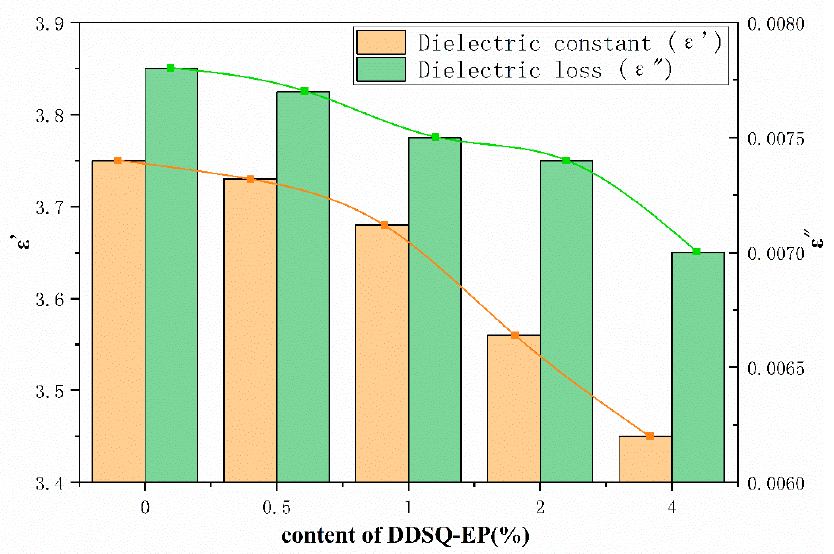
Figure 13. Dielectric constant ( ε′ ) and dielectric loss ( ε″ ) results of PBZ/DDSQ-EP with different DDSQ-EP content.